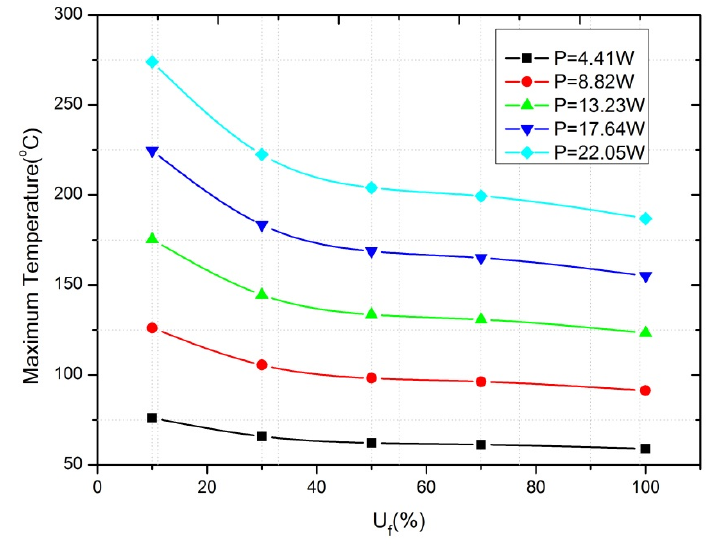
Figure 11. The effect of heating uniformity on the maximum temperature of TEG.